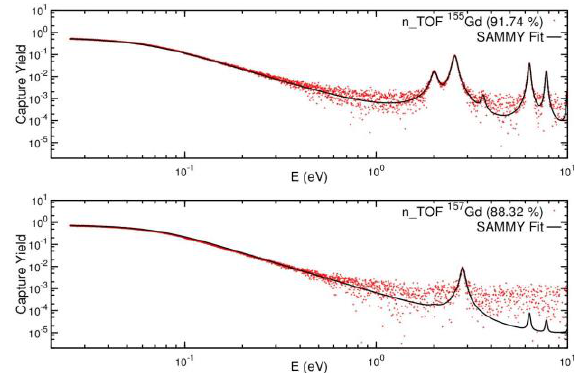
Fig. 1. Comparisons of SAMMY calculations with the resonance parameter (solid line) of the capture yield of the n_TOF data in the energy region 0.02 eV to 10 eV.